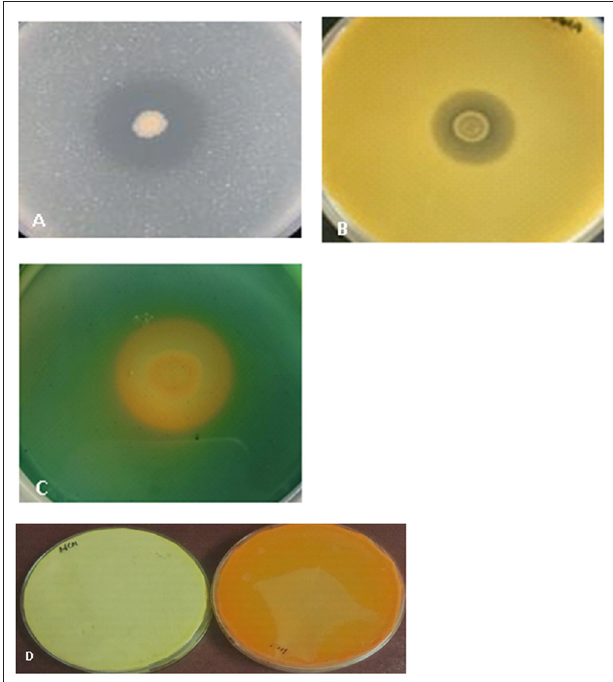
FIGURE 2 | The selected isolates were tested for production of the following. (A) Chitinase- The zone of clearance shows hydrolysis of chitin by the isolate, (B) Protease- The clear zone surrounding the colony shows the production of protease enzyme by the isolate. (C) Siderophore- The orangish-yellow zone around the colony shows the isolate is positive for siderophore production. (D) HCN- The change of color of filter paper from yellow (control) to orangish brown is indicative of the production of HCN by the